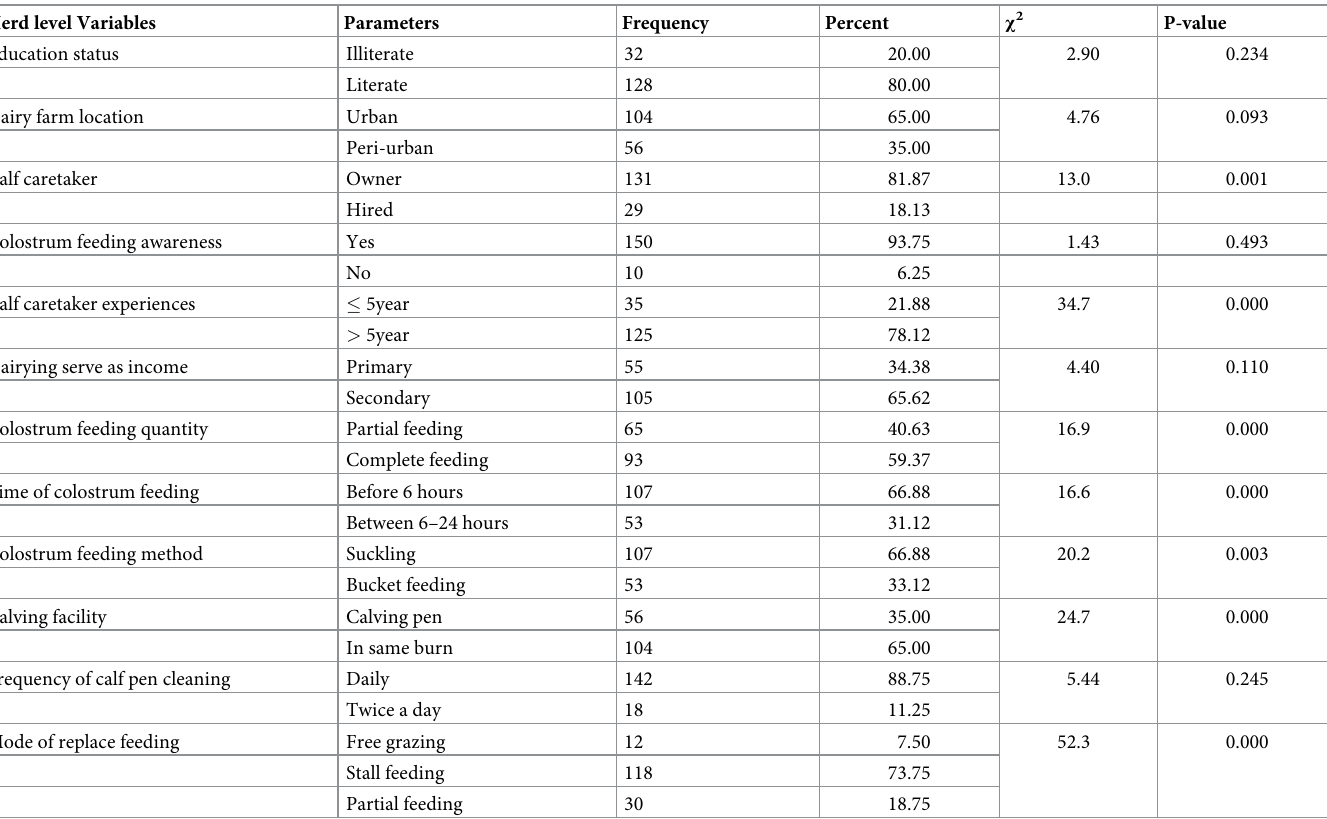
Table 2. Association of herd level household characteristics, farm management practices with calf health and mortality problems in farms within 1 year (N =